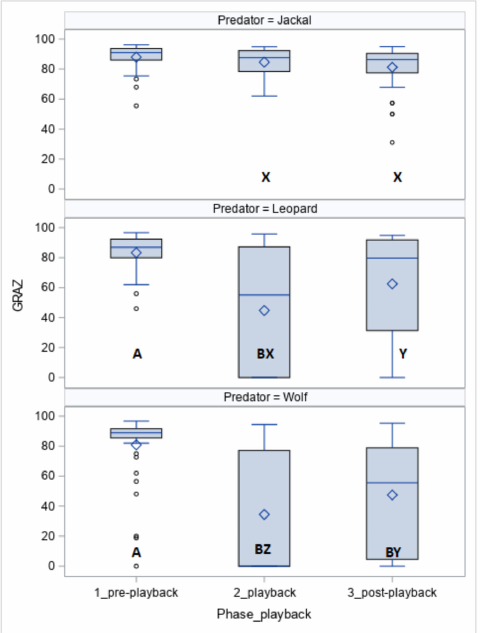
Figure 2. Duration of grazing (GRAZ; %) in horses exposed to the vocalisation of the jackal, leopard and wolf. Values with A, B letters di ff er significantly at p < 0.01 between phases 1–3 (pre-, playback and post-playback); values with X, Y, Z letters di ff ers significantly at p < 0.01 between predators; values with no letter do not di ff er to other